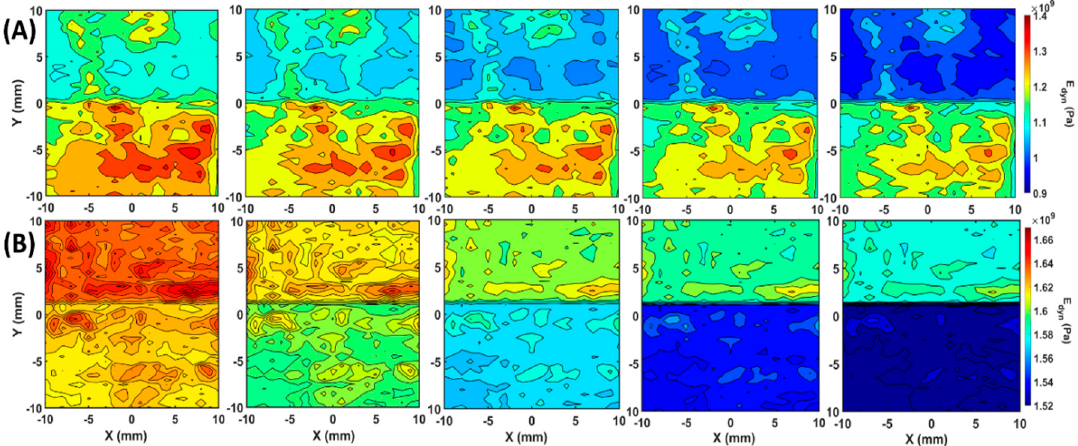
Figure 7. Angle-depedendent dynamic Young’s modulus distribution maps calculated by the K dyn and G dyn by Equation (5). Row ( A ), from left to right, the dynamic shear modulus maps at 0 ◦ , 22.5 ◦ , 45 ◦ , 67.5 ◦ and 90 ◦ of sample 1. Row ( B ), from left to right, the dynamic shear modulus maps at 0°, 22.5°, 45°, 67.5° and 90° of sample 2.